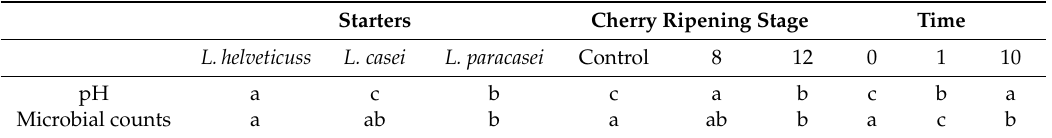
Table 4. Homogeneous groups as determined by Tukey’s multiple range test ( p < 0.05) for pH and microbial counts determined in fermented milks with addition of sweet cherry, independent factors: starter culture ( L. helveticuss, L. casei, L. paracasei ), cherry ripening stage (control: without addition of sweet cherry; 8: with addition of sweet cherry in a ripe stage 8; 12: with addition of sweet cherry in a ripe stage 12) and time (0 pre-fermentation, and 1, and 10 days of refrigerated